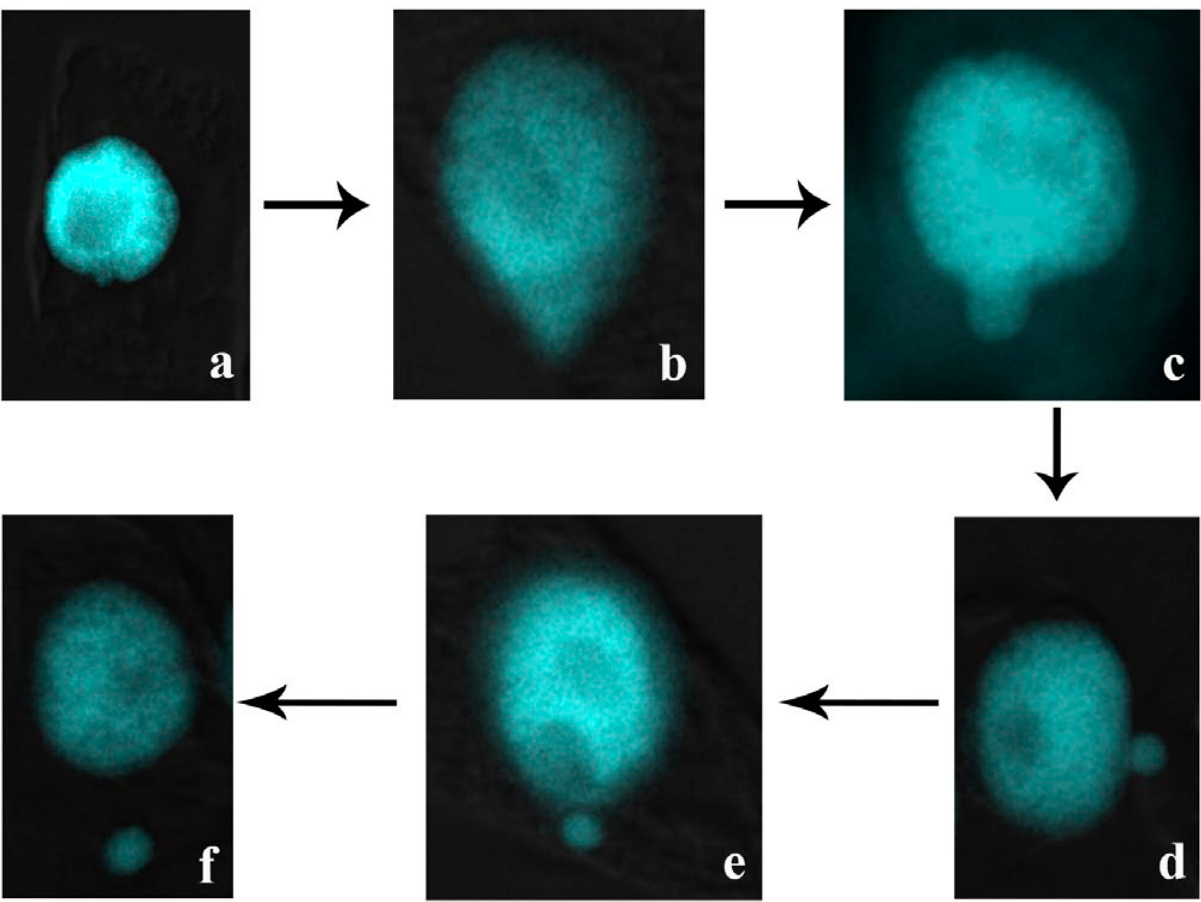
Fig. 5. Various stages of nuclear budding induced by extract of C. viminale . a: initiation of bud; b: growth of bud; c: protruding as fully formed bud; d: bud with a basal notch; e: detachment of bud from the nucleus; f: